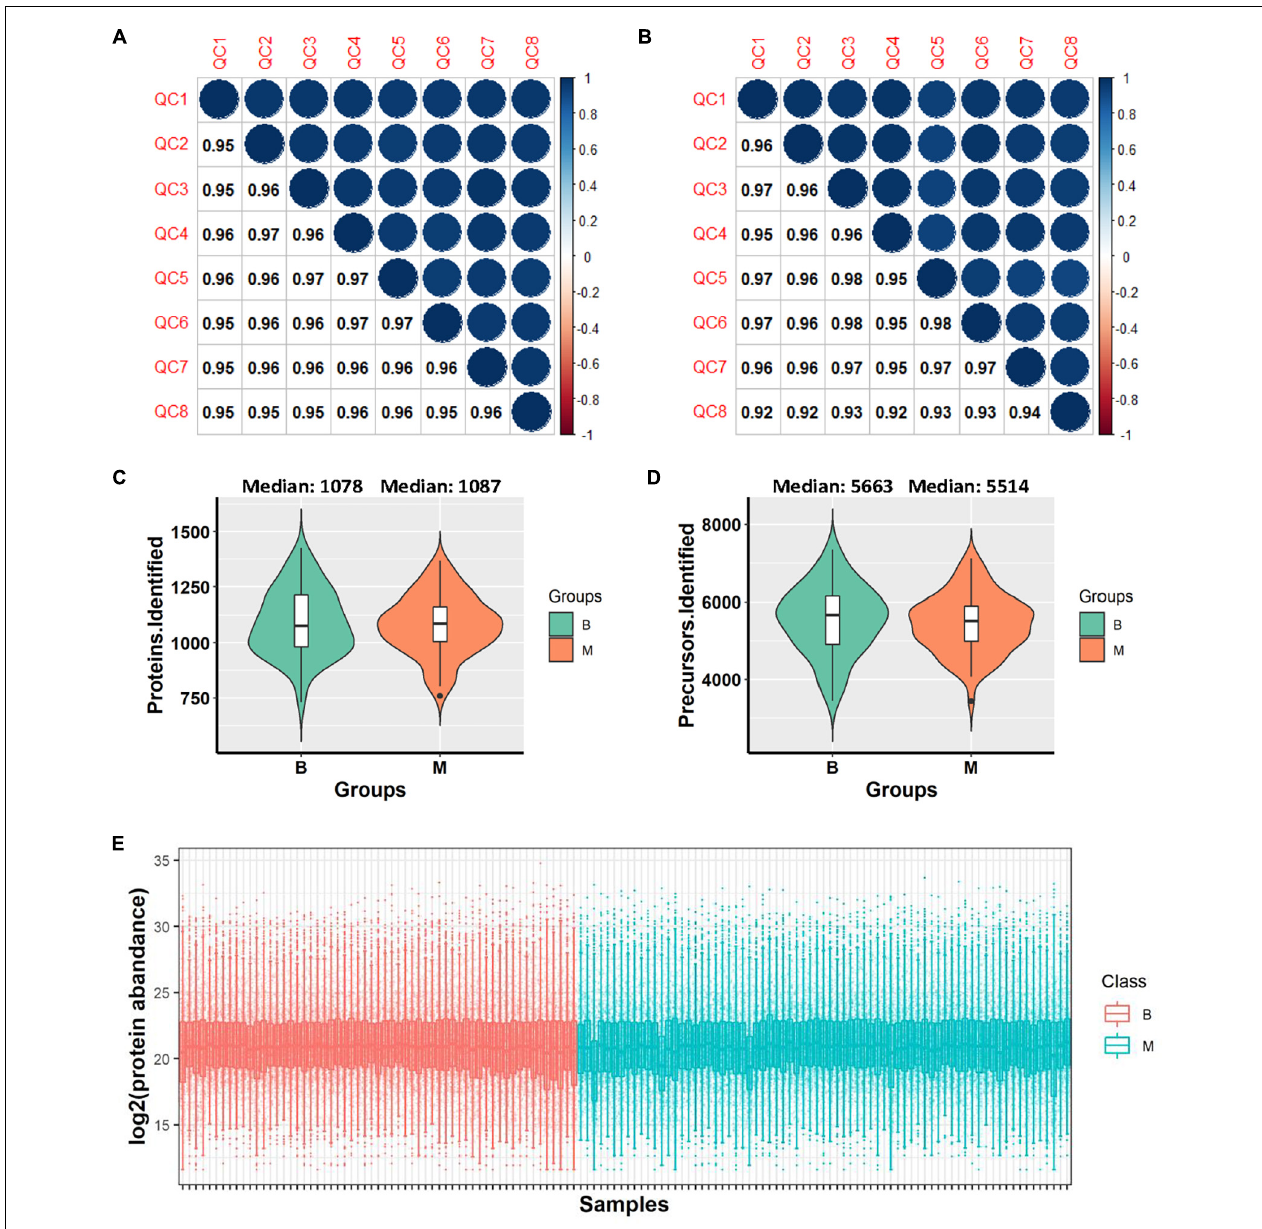
FIGURE 2 | Data quality evaluation. (A) Pearson correlation of 8 HeLa cell lysate samples in all batches for evaluation of the reproducibility of mass spectrometry. (B) Pearson correlation of 8 repeat-tested urine samples in all batches for evaluation of the reproducibility of methodology. (C) Violin plot of protein identification numbers in benign and malignant groups. (D) Violin plot of precursor identification numbers in benign and malignant groups. (E) Box plot of protein abundance in each sample. *B, benign group; M, malignant group.